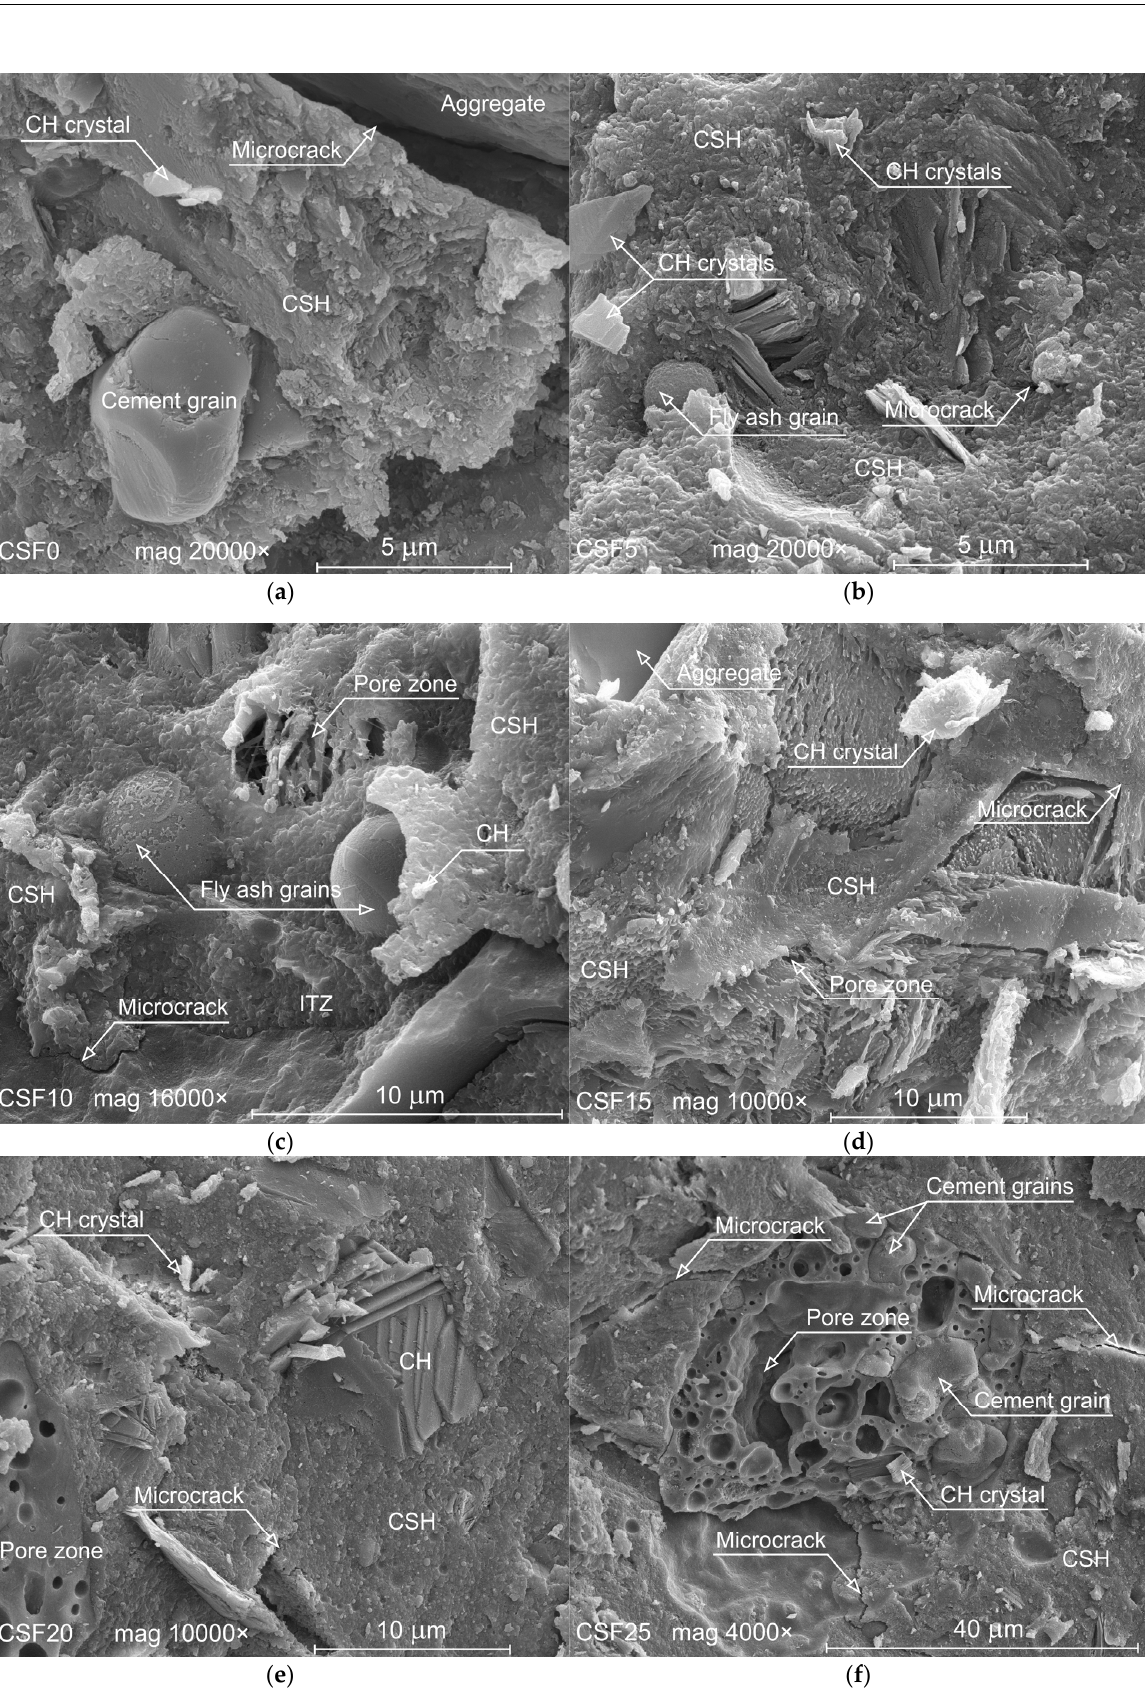
Figure 12. SEM microphotographs in 200× magnification for HPC with CSF content of ( a ) 0%; ( b )